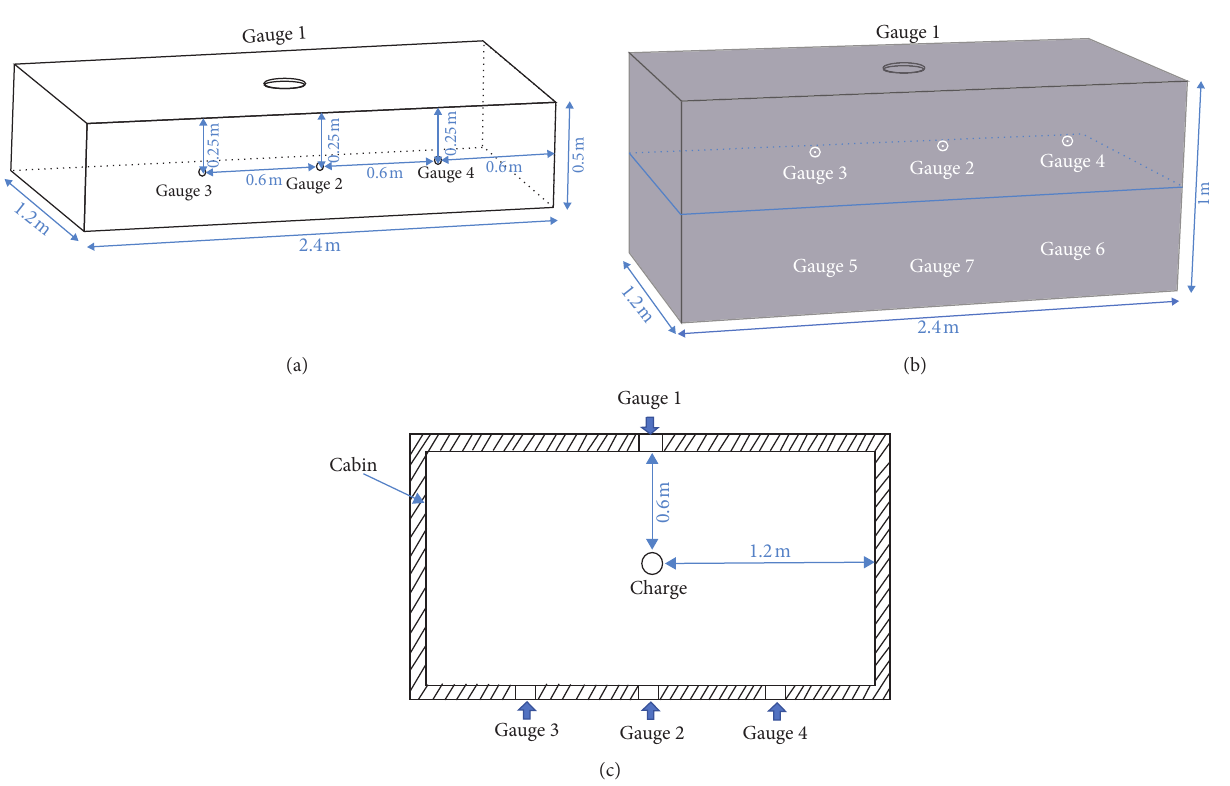
Figure 1: Schematic diagram of the simulated chamber layout. (a) Simulated chamber 1. (b) Simulated chamber 2. (c) Top view of simulation chamber.